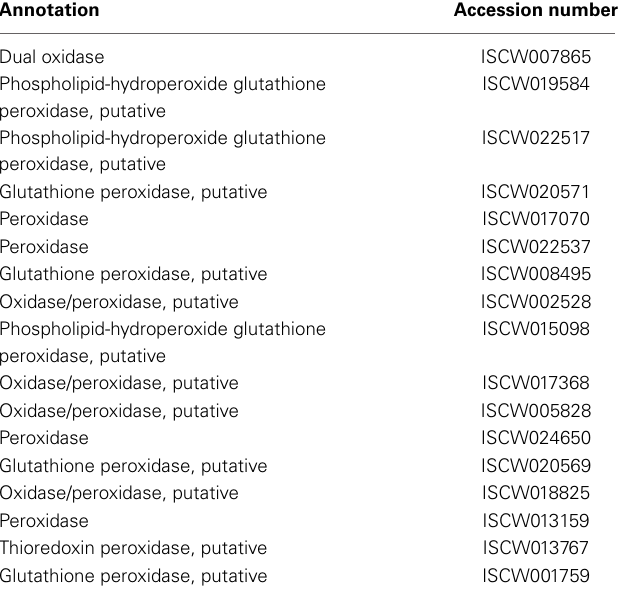
Table 1 | Gut-microbe